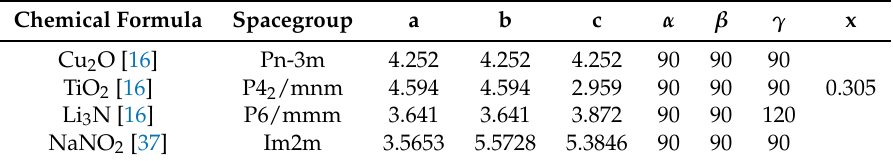
Table 1. Structural information used for calculations in VASP . The lattice parameters of the unit cell a , b , c are given in angstroms and angles between the lattice vectors α , β , γ are given in degrees. The internal parameter x is defined for the associated space group and can be used, with the lattice parameters, to fully construct the unit cell. Citations are given after the chemical formula. Chemical Formula Spacegroup a b c α β